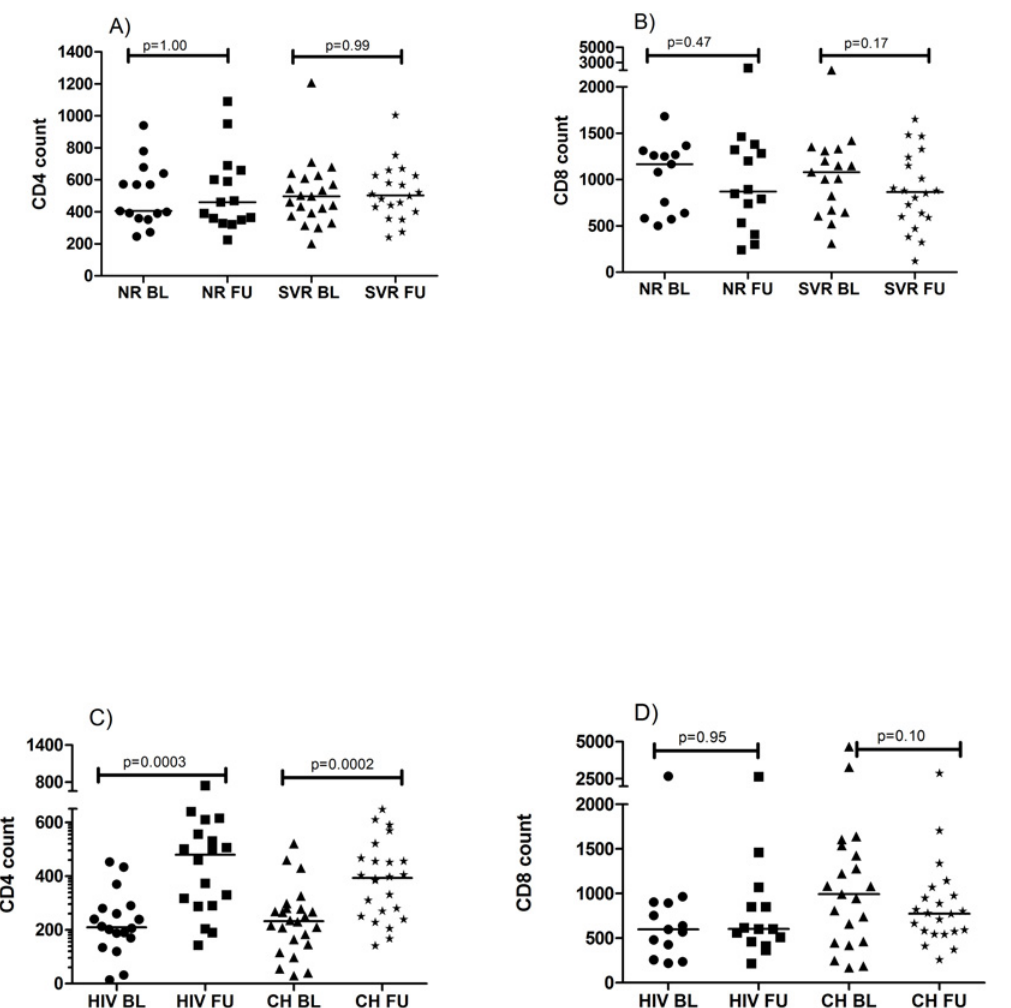
Fig 2. Kinetics of CD4 and CD8 T cell counts. Baseline (BL) and Follow-up (FU) of CD4 + T cell counts and CD8+ T cell counts during the study time were compared between Sustained viral responders (SVR) and non-responder (NR) group (A-B) and between HIV and HCV chronic (CH) group (C-D). Changes between baseline and follow-up were assessed by Wilcoxon matched-pairs signed rank-test; p (cid:3) 0.05 was considered